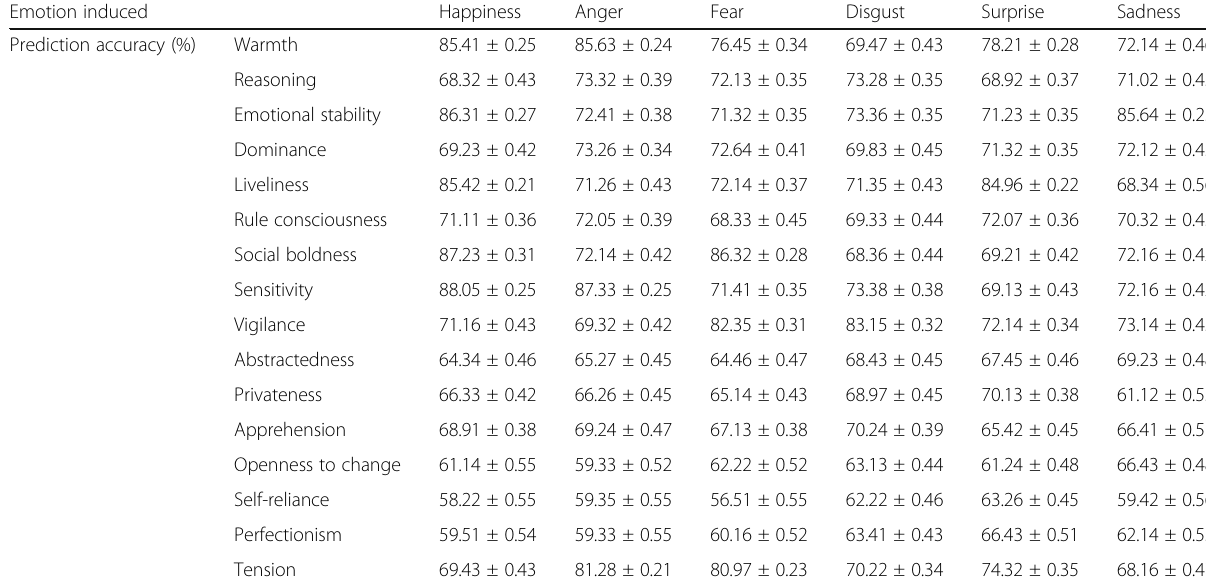
Table 5 16PF traits ’ prediction accuracy for inter-subject tests based on test sample induced emotion Emotion induced Prediction accuracy (%)